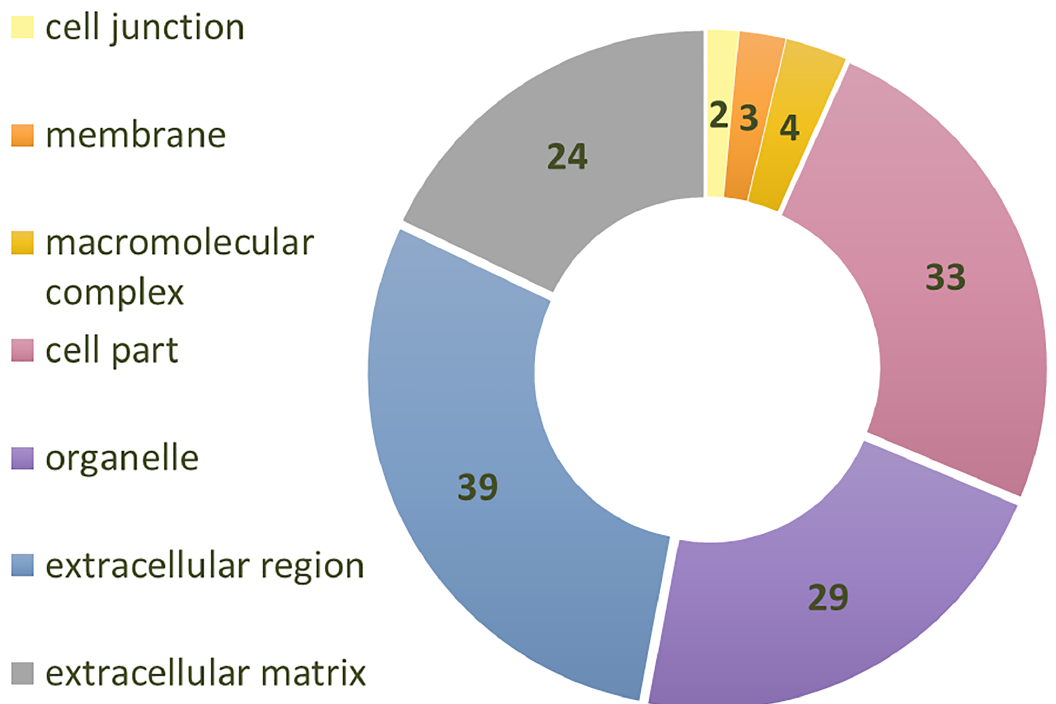
Fig 1. The number of proteins in each cellular compartment of the proteome extracted from supraspinatus tendon samples using tryptic digestion. 126 identifiedproteins(Progenesis, at least 2 identifiedpeptides)were categorizedusing PANTHER